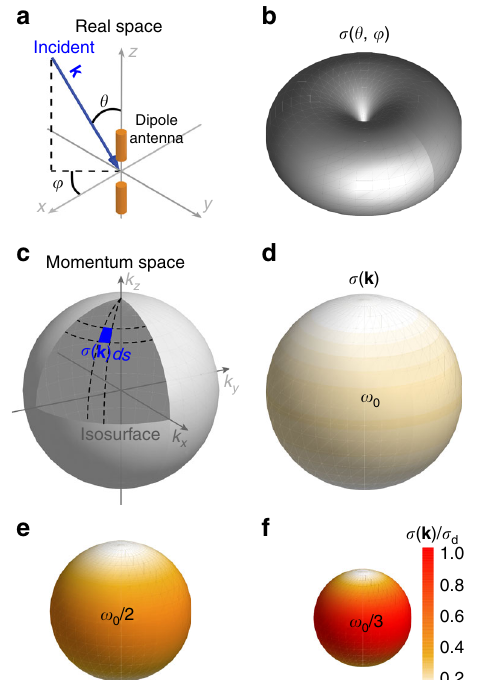
Fig. 2 Scaling law of resonant cross sections in momentum space. a Schematic of a dipole antenna in free space. b Real-space representation of scattering cross section σ θ ; φ ð Þ . c In the momentum space, the cross section is represented by σ ð k Þ , with k located on the isosurface de fi ned by the resonant frequency. d The cross section σ ð k Þ of the dipole antenna is represented by the colour intensity on the isosurface. e The cross section of a dipole antenna operating at a lower resonant frequency of ω 0 = 2. The isosurface shrinks by half compared to d . The cross section increases as indicated by stronger colours. f Same as e but with an even smaller resonant frequency of ω 0 = 3. d , e and f all use the same colour map so that the cross section can be directly compared. The cross section is normalized = 2 by σ d ¼ 27 λ 2 0